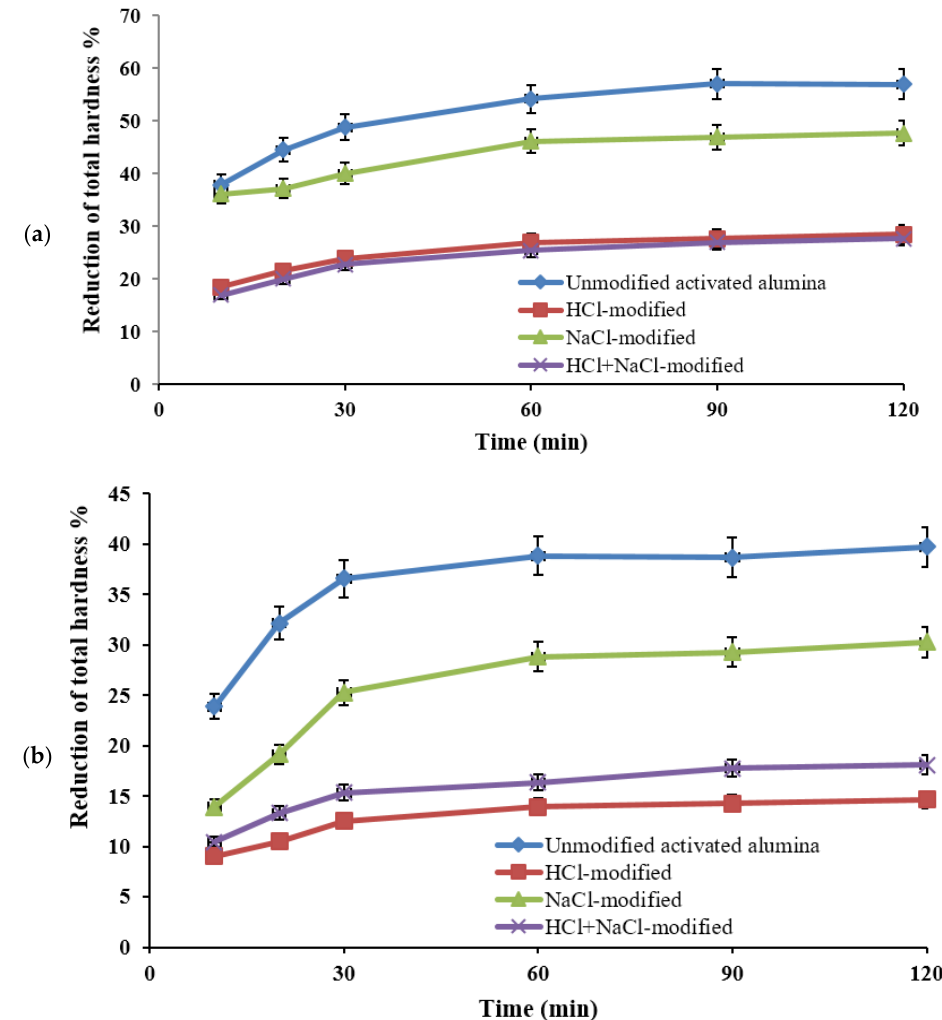
Figure 12. The effect of contact time on the decrease in total hardness (%) of ( a ) drinking water by modified activated alumina with a concentration of 60 g/L and ( b ) groundwater by modified activated alumina with a concentration of 40 g/L.